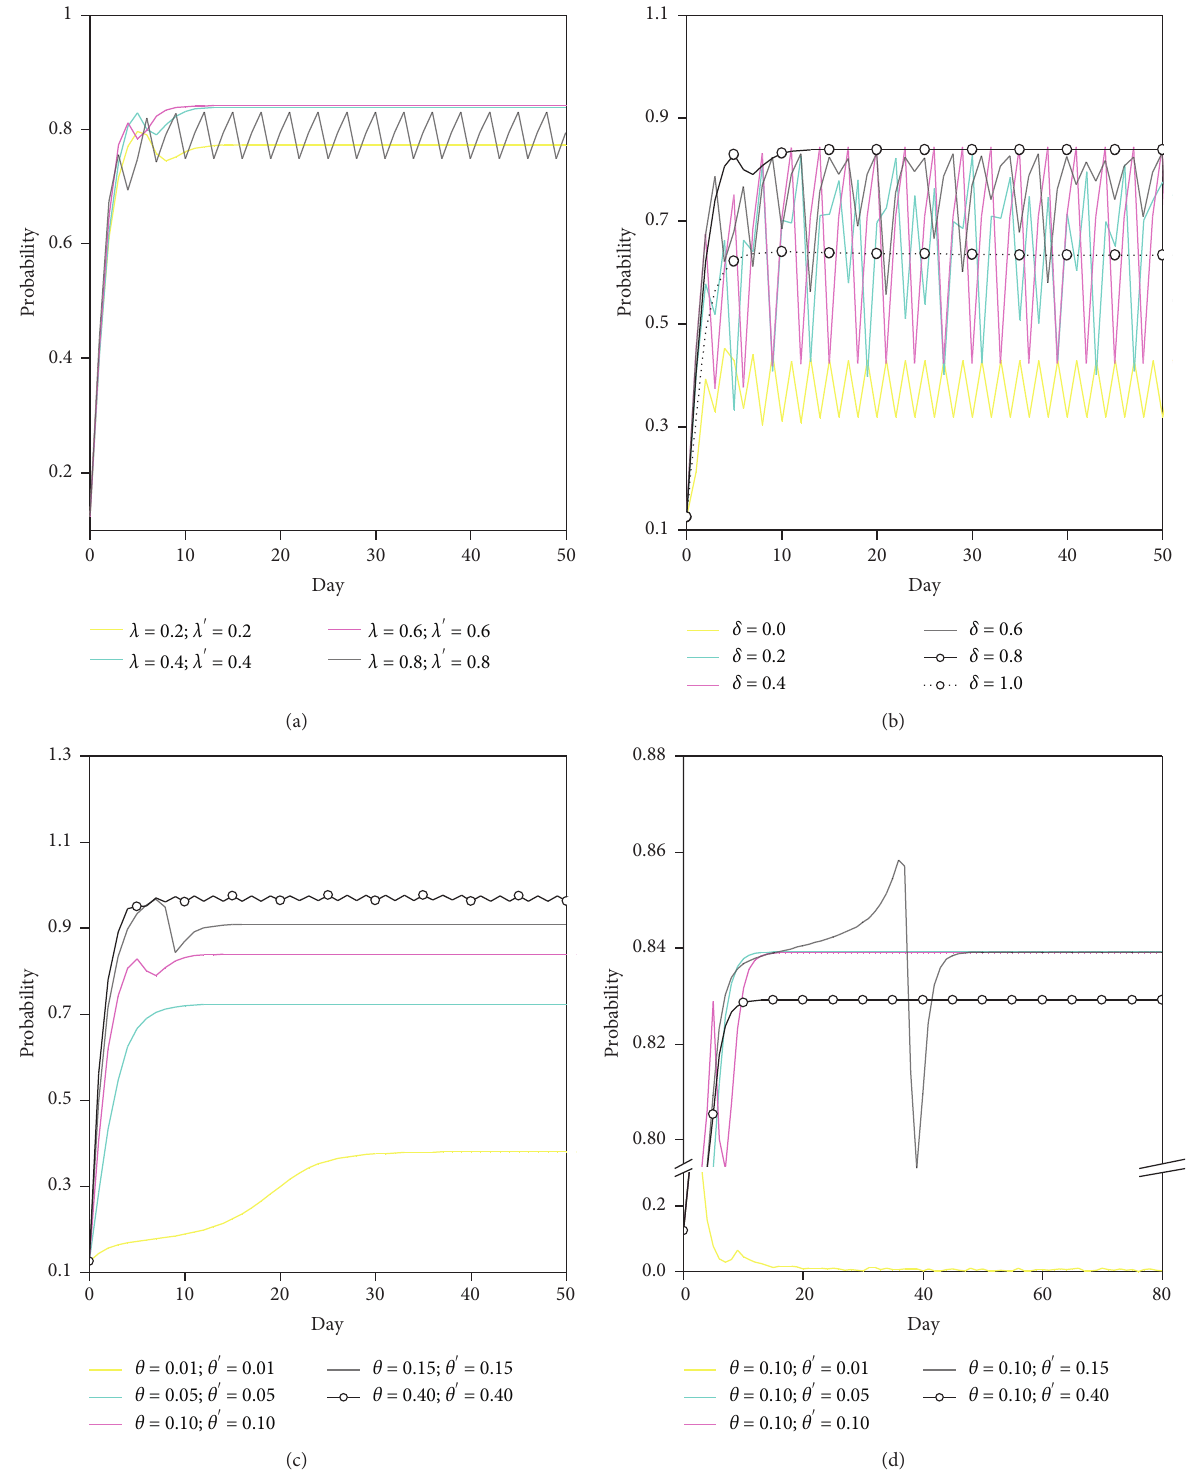
Figure 5: Evolutionary processes under different parameter values: (a) λ � λ